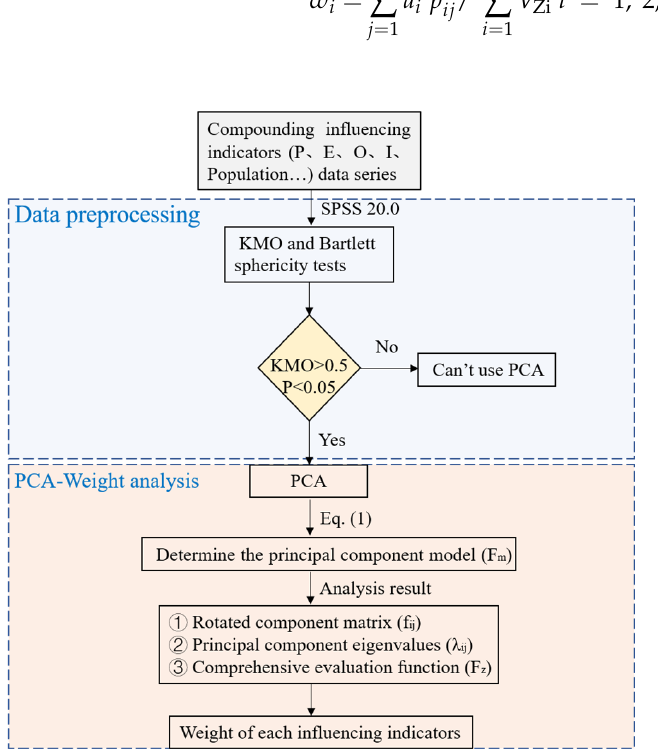
Figure 2. Principal component method—Flowchart of weight analysis.